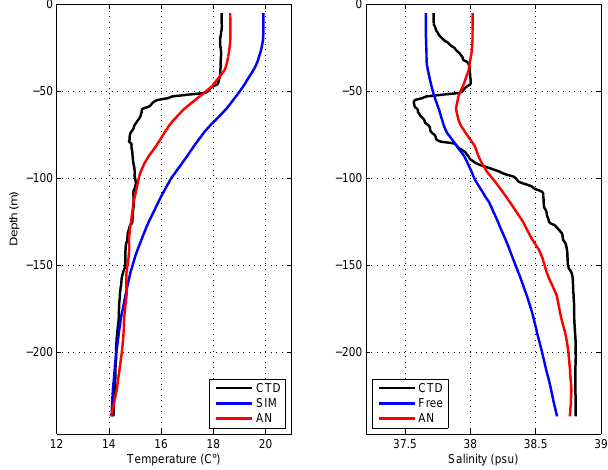
Fig. 8. Eastward transport ( Sv ) at the Sicily Strait (daily time se- Fig.8. Eastwardtransport( Sv )attheSicilyStrait(dailytimeseriessmoothedthrough30-daysmovingaverage)forAN(reddashedline) ries smoothed through 30-days moving average) for AN (red dashed andSIM(bluefullline). line) and SIM (blue full line).